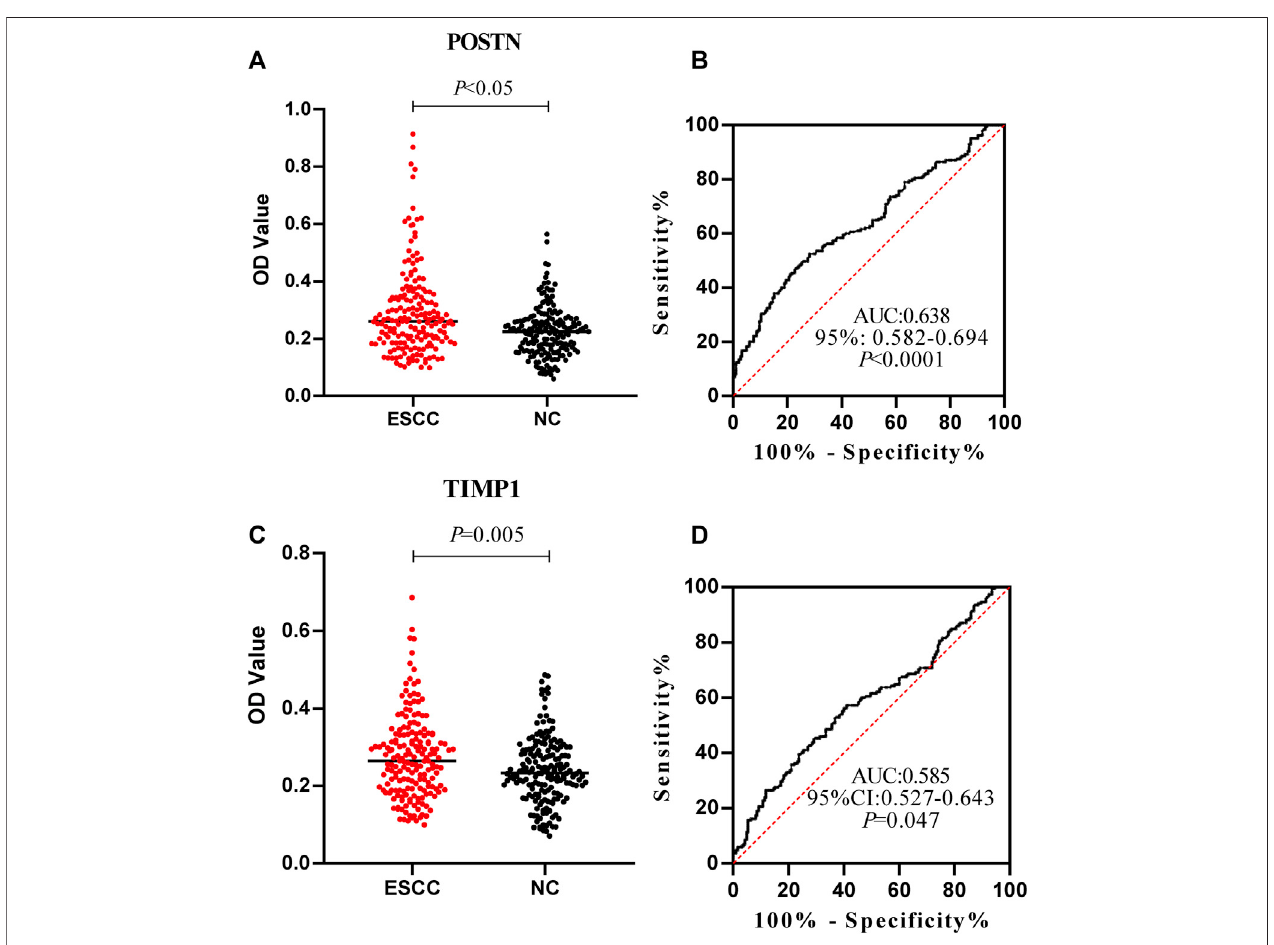
FIGURE 4 | Expression level and diagnostic value of anti-POSTN and anti-TIMP1 autoantibodies in ESCC patients and normal controls. (A,C) Scatter plot describedtheexpressionlevelofanti-POSTNandanti-TIMP1autoantibodiesintheESCCgroupandnormalcontrolgroup. (B,D) Receiveroperatingcharacteristiccurve of anti-POSTN and anti-TIMP1 autoantibodies in diagnosing ESCC patients and normal controls. ESCC, esophageal squamous cell carcinoma; NC, normal controls.